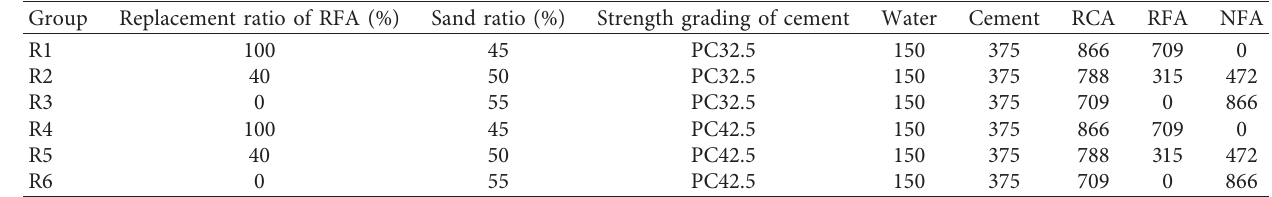
Table 3: Mixture proportions of RCB (kg/m 3 ).